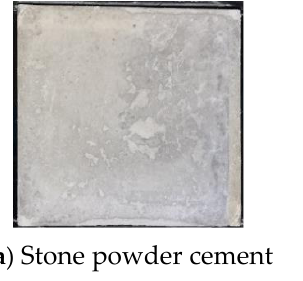
Figure 11. Destruction images of hardened bodies in natural state.